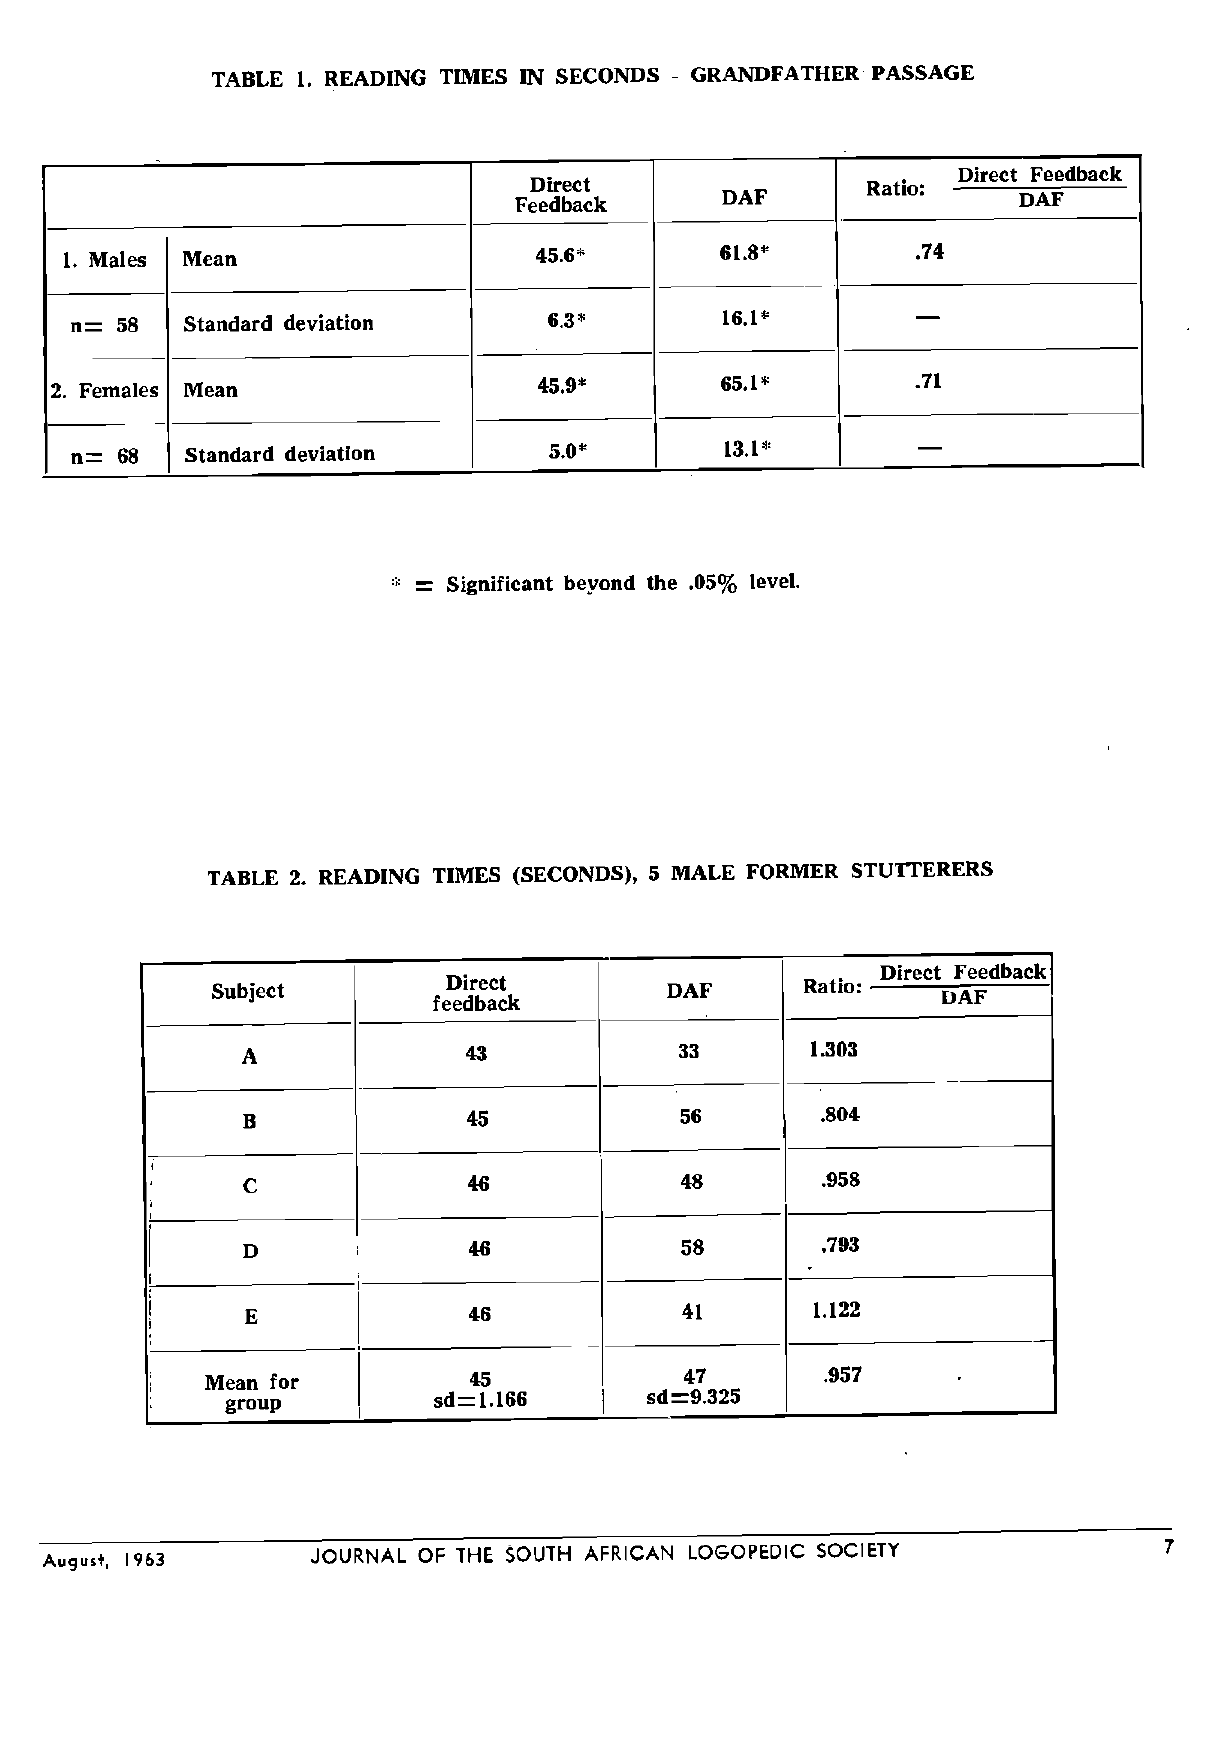
TABLE 1. READING TIMES IN SECONDS - GRANDFATHER PASSAGE